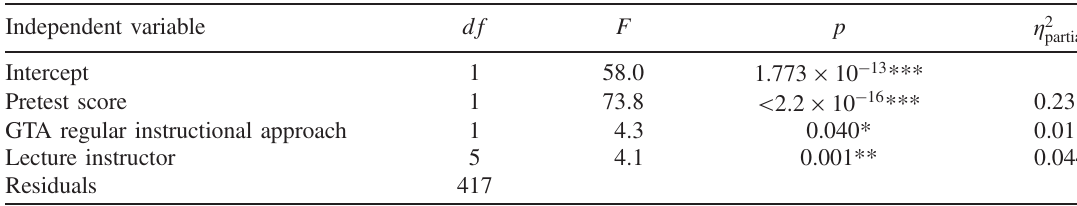
TABLE XIV. Results of two-way ANCOVA (type III) conducted on student performance on FCI posttest in Physics I with lecture instructor and GTA regular approach as independent variables and pretest score as a covariate. Heteroscedasticity correction was conducted.